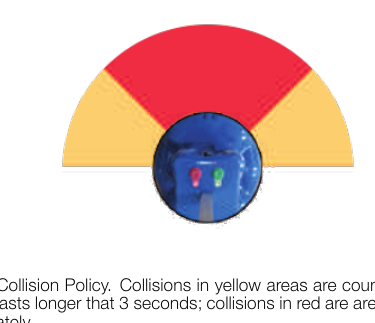
Figure 8. Collision Policy. Collisions in yellow areas are counted if the contact lasts longer that 3 seconds; collisions in red are are counted immedi- ately.